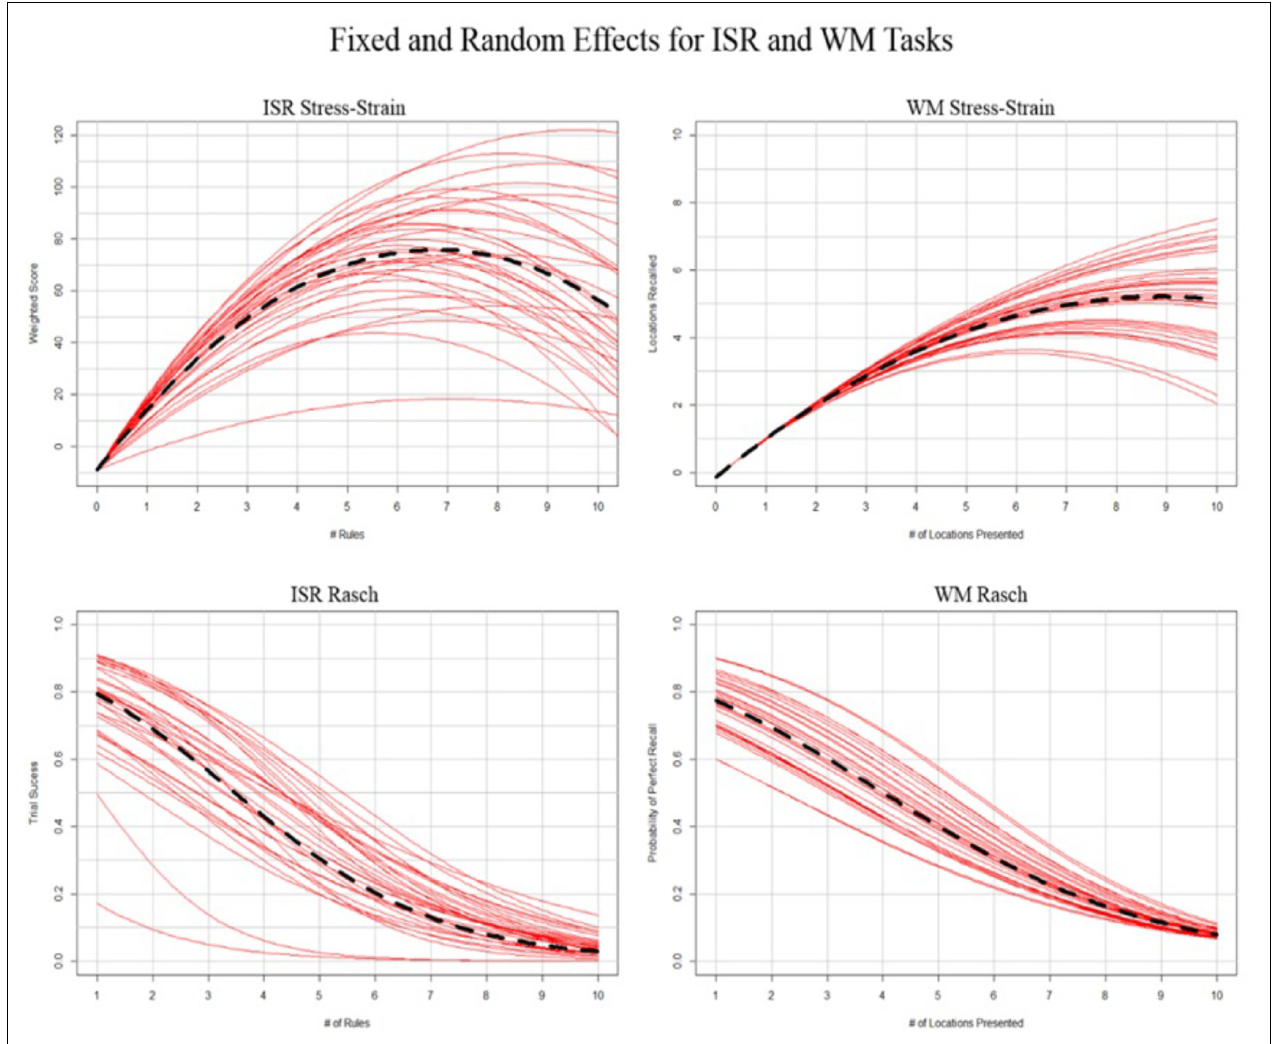
FIGURE 3 | Representation of general (left) and generalized (right) mixed effects regressions. Black hashed line depicts fixed effects, and red lines depict random effects conditioned on individual participants.